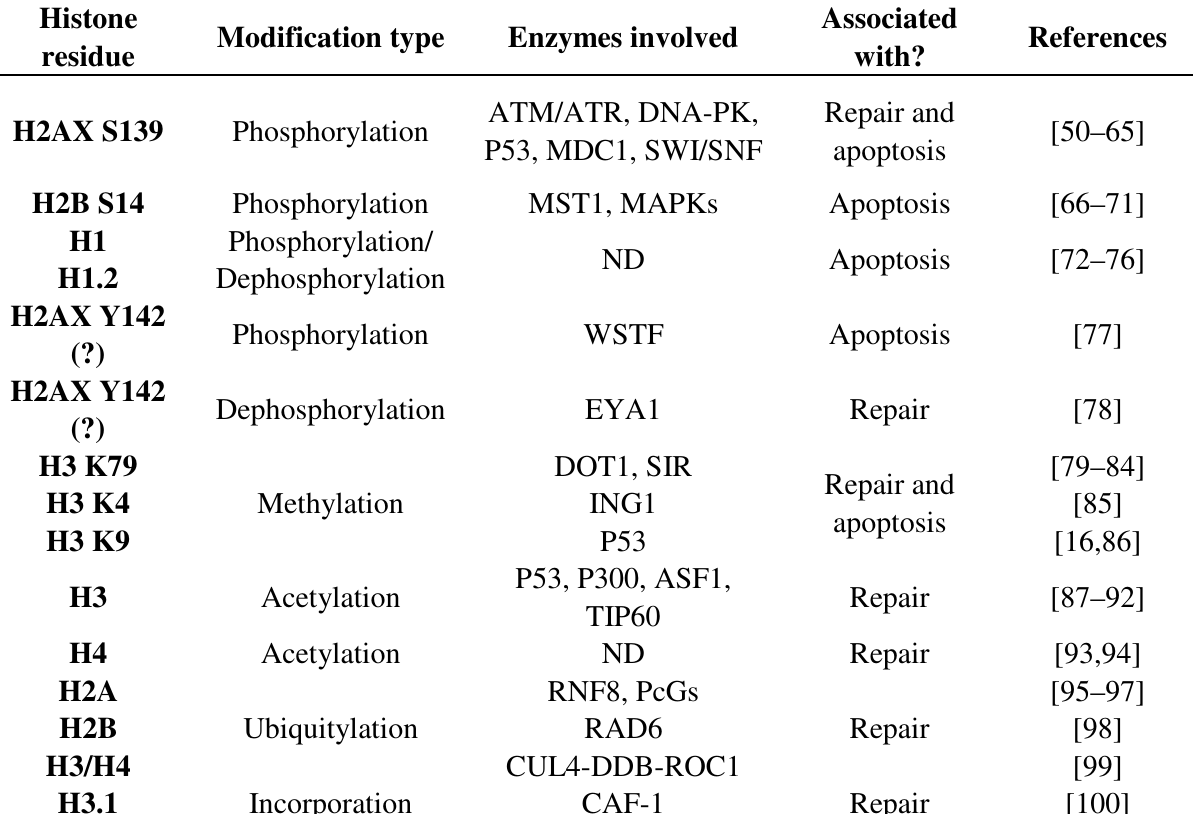
Table 1. Post-translational modifications following UV damage and their association with repair and/or apoptosis. ND = Not